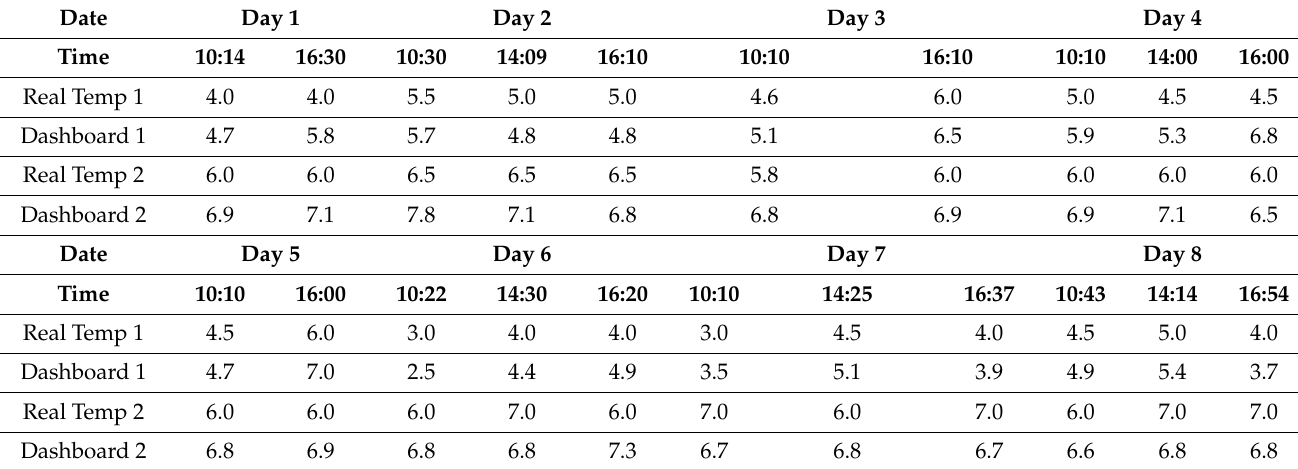
Table 6. Temperatures of Pharmaceutical Refrigerators Using Hospital Network.